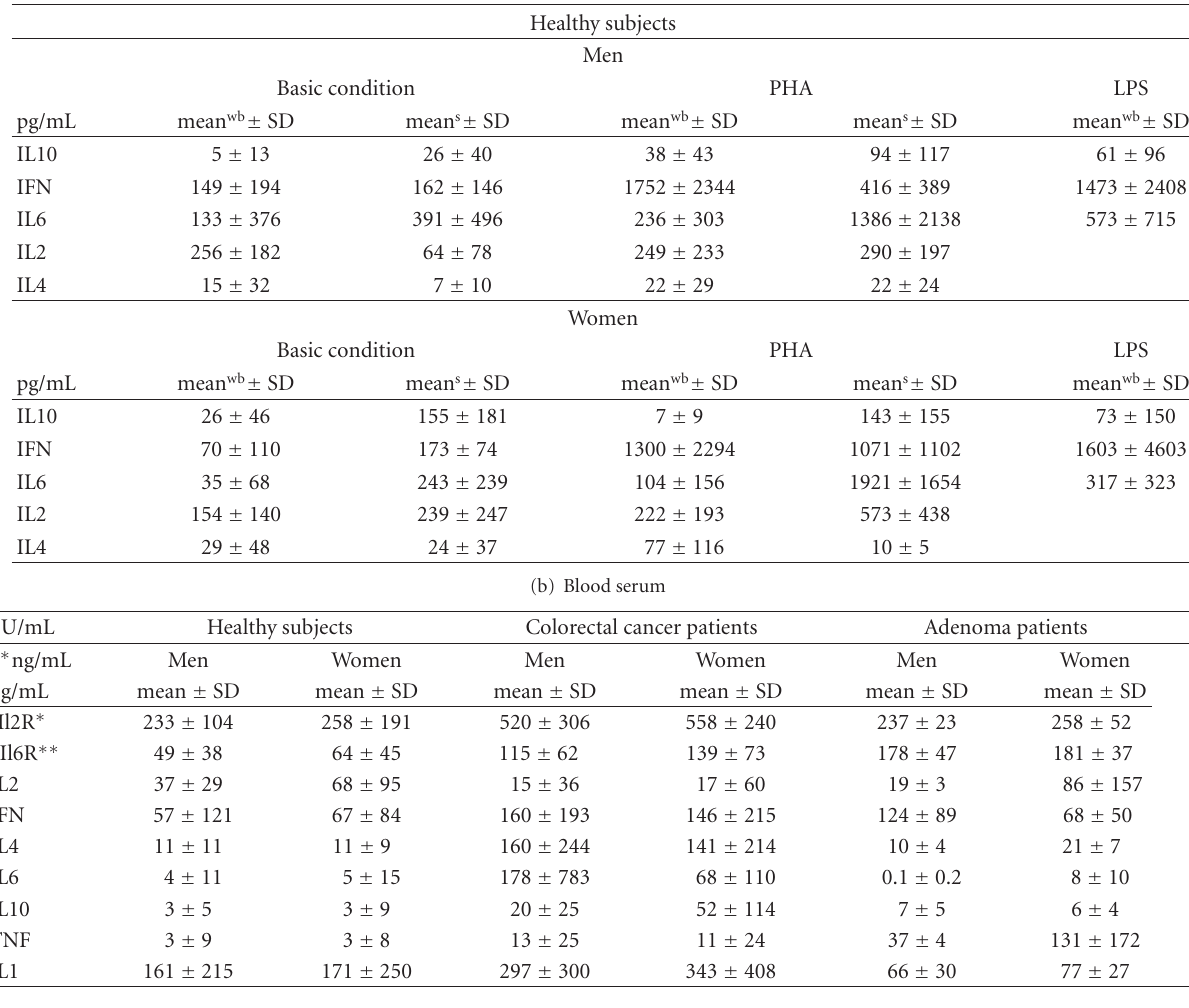
Table 1: Cytokine levels were determined in (1) whole blood (wb) and PBMC supernatant (s) in physiological conditions (basic conditions) and after stimulation with PHA (to study T cell network contribution) and LPS (to evaluate the influence of antigen presenting cells) (2) in blood serum. The levels are expressed as mean ± SD and statistical di ff erences between men and women were assessed using the Mann- Whitney U-test or Student’s t -test as appropriate. Production levels of cytokines did not di ff er significantly with the exception of IL10 (using the wb method) which was higher in men than in women when PHA stimulus was used ( P = 0 .